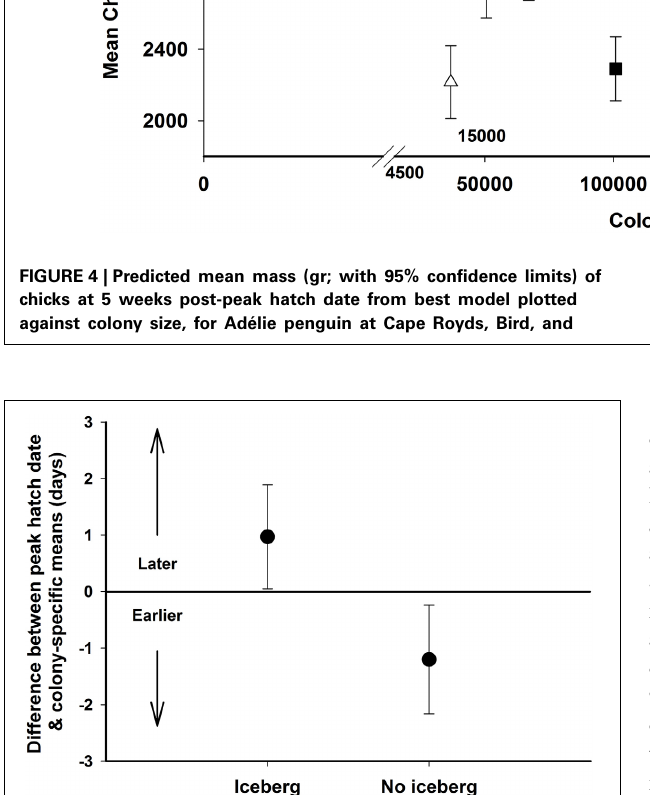
FIGURE 5 | The mean difference (with 95% confidence limits) between peak hatch date and colony-specific means for Adélie penguin s breeding at Cape Royds, Bird, and Crozier on Ross Island, Antarctica during years when the icebergs were present (2001–2005) and